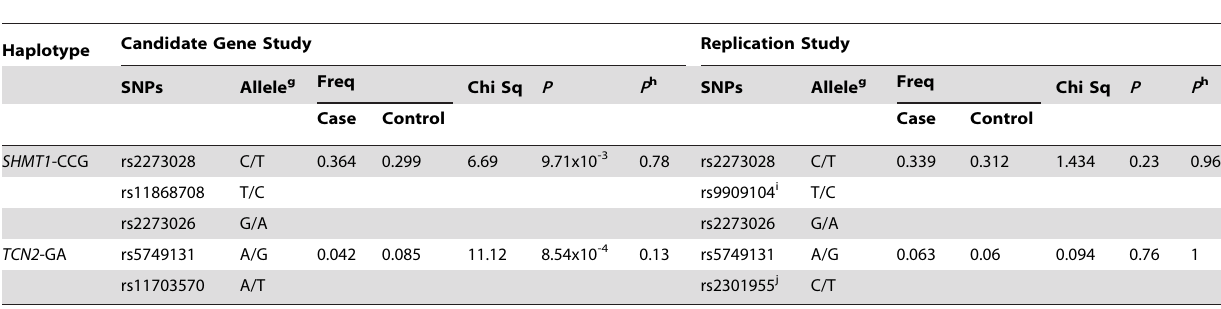
Table 3 . Haplotype Frequencies Distributions of Significant Haplotype Blocks among Cases and Controls.